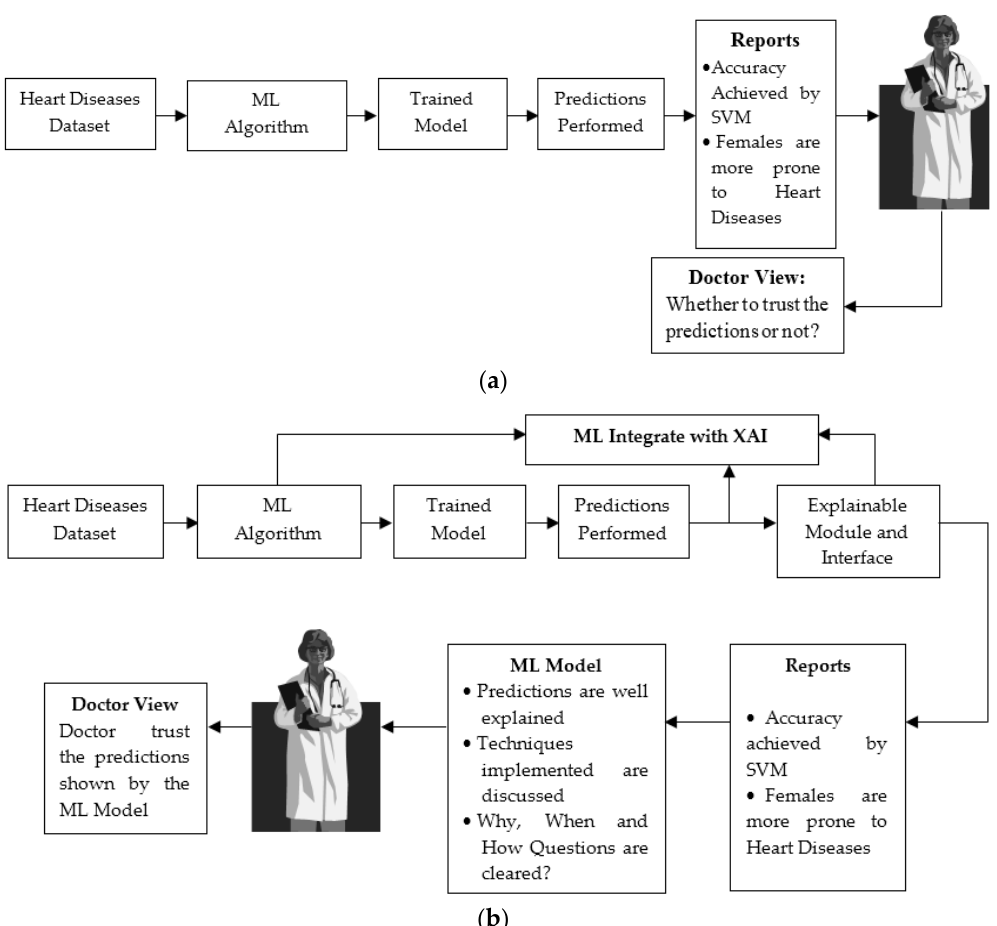
Figure 1. ( a ) ML approach followed without explainable AI. ( b ) improvised ML approach followed with explainable